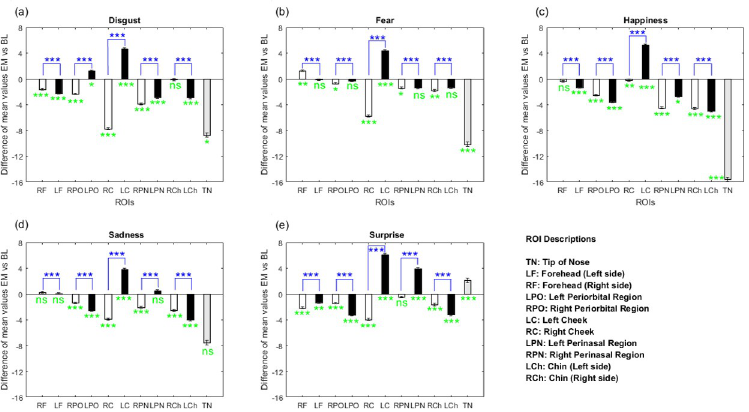
Fig 6. Emissivity variation analysis in the selected ROIs, considering the five emotions, taking as reference the baseline (in green) and the ROI pairs (in blue). The green highlights (below line 0) indicate the significance of emissivity variations in the ROIs triggered by each emotion in relation to the baseline. The blue highlights (above line 0) indicate the significance of emissivity variations occurred between the bilateral ROIs to verify the facial thermal asymmetry. Legend: EM vs BL means Emotion versus Baseline; ns means no significant emissivity variation ( p-value > 0.05), while � ( p-value � 0.05), �� ( p-value � 0.01) and ��� ( p-value � 0.001) indicate significant emissivity variation.